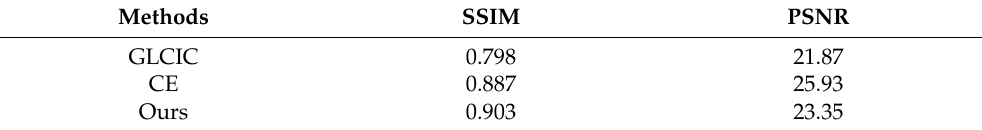
Table 1. Comparison of the center rectangle masked completion results on the CelebA-HQ dataset.